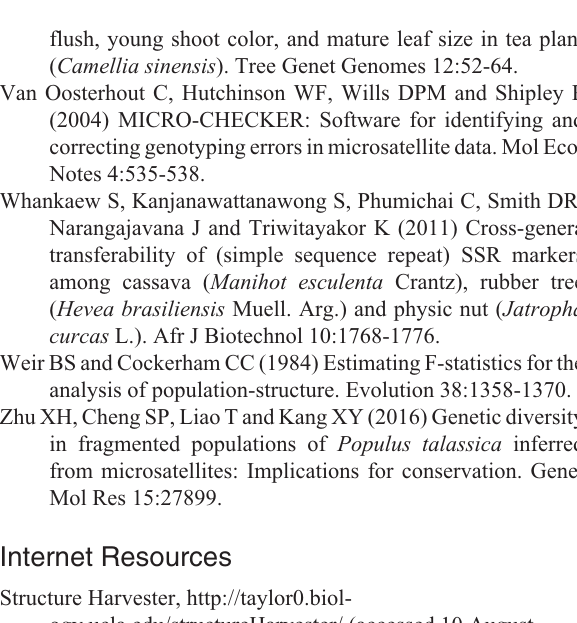
Table S1 - Characteristics of 20 microsatellite loci tested for transferability. Table S2 - Transferability results of the SSR markers for populations. Table S3 - PCR conditions for the SSR markers transferred. Table S4 - Private alleles (> 10% frequency) found in each locus per population. Table S5 - F-statistics by locus for all populations and FST corrected by ENA method. Table S6 - Results of a literature